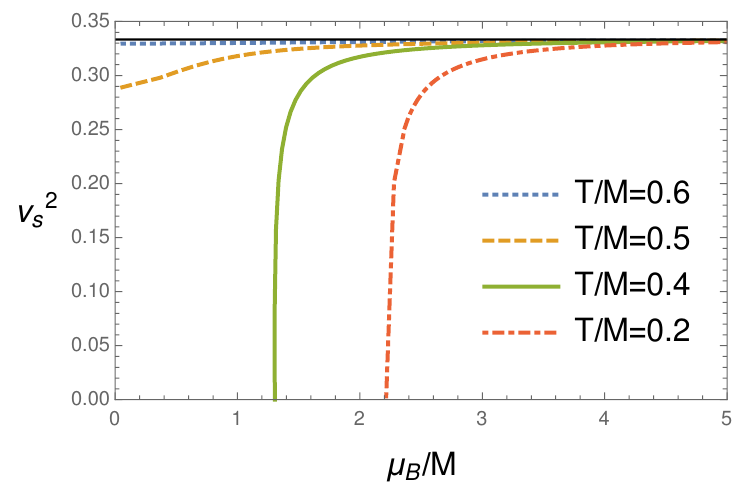
Figure 4 . Speed of sound squared. The horizontal black line corresponds to the conformal value of 1 = 3. We observe that the speed of sound decreases rapidly to zero when the boundary of the phase diagram is